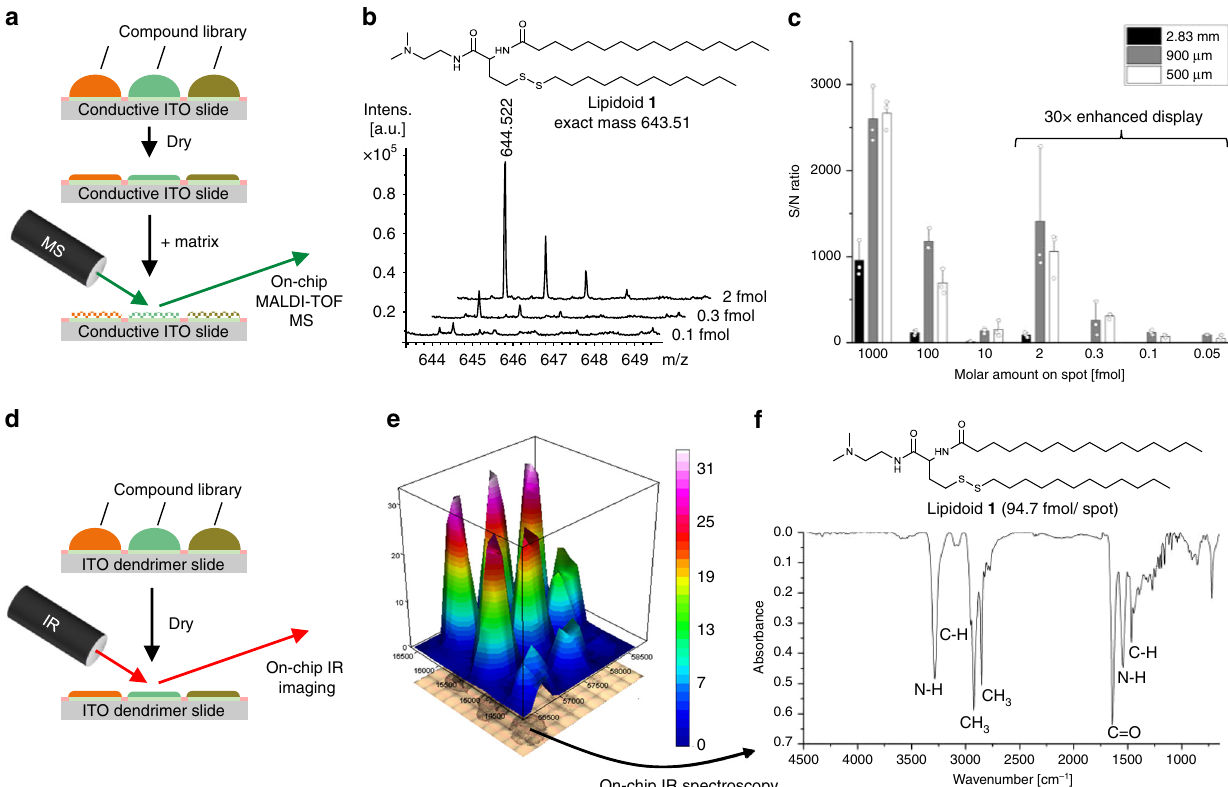
Fig. 4 Indium-tin oxide substrates enable on-chip characterization by MALDI-TOF mass spectrometry and IR spectroscopy. a Schematic showing the process of on-chip characterization by MALDI-TOF MS. A compound library generated on a conductive, dendrimer-modi fi ed, and patterned ITO slide can be processed and co-crystallized with matrix solution prior to MALDI-TOF analysis. b MALDI-TOF mass spectra of 2, 0.3, and 0.1 fmol per spot of lipidoid 1. Spot diameter: 500 µ m; spot distance: 250 µ m. The MALDI-TOF measurements were performed on patterned ITO glass slides. c Bar chart showing signal- to-noise (S/N) ratio obtained from on-chip MS analysis of lipidoid 1 in spots of different sizes. Data represent mean ± standard deviation based on triplicate experiments; n = 3 independent experiments. d Schematic diagram showing the process of on-chip characterization by IR spectroscopy. Non-invasive, on- chip characterization of a compound library by IR spectroscopy acquired after evaporation of the solvent. e On-chip IR imaging of several spots containing different amounts of lipidoid 1 per spot. Color scale: Absorbance [a.u.]. f IR spectrum of lipidoid 1 (94.7 fmol per spot). Spot diameter: 500 µ m; spot distance: 250 µ m. Source data are provided as a Source Data fi